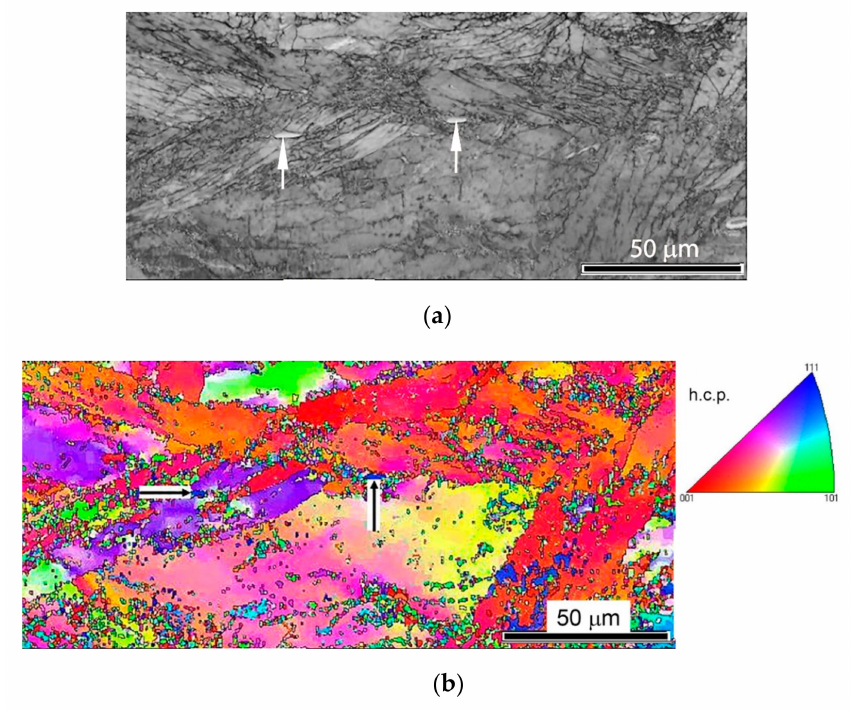
Figure 15. The SEM-EBSD images of Ti64LM specimen SHPB tested at 2030 s − 1 : ( a ) band contrast image, ( b ) EBSD orientation map - arrows indicate small secondary cracks appeared inside α